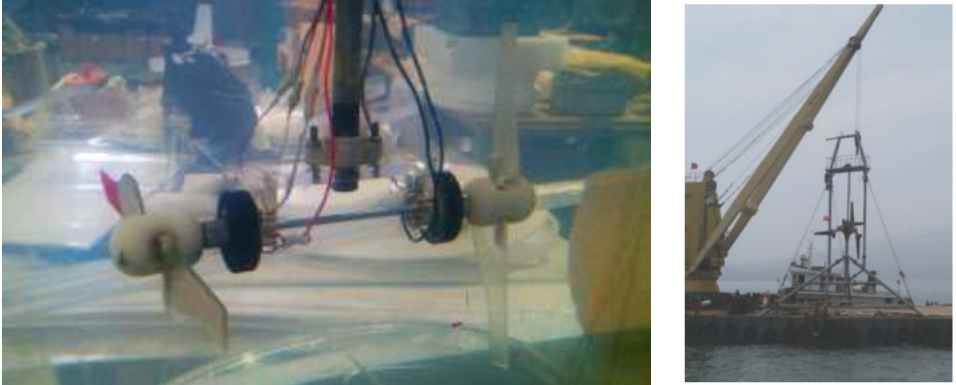
Figure 12. The model and prototype of 15 kW common horizontal-axis self-variable-pitch TCPGS. Reproduced from [17,35].